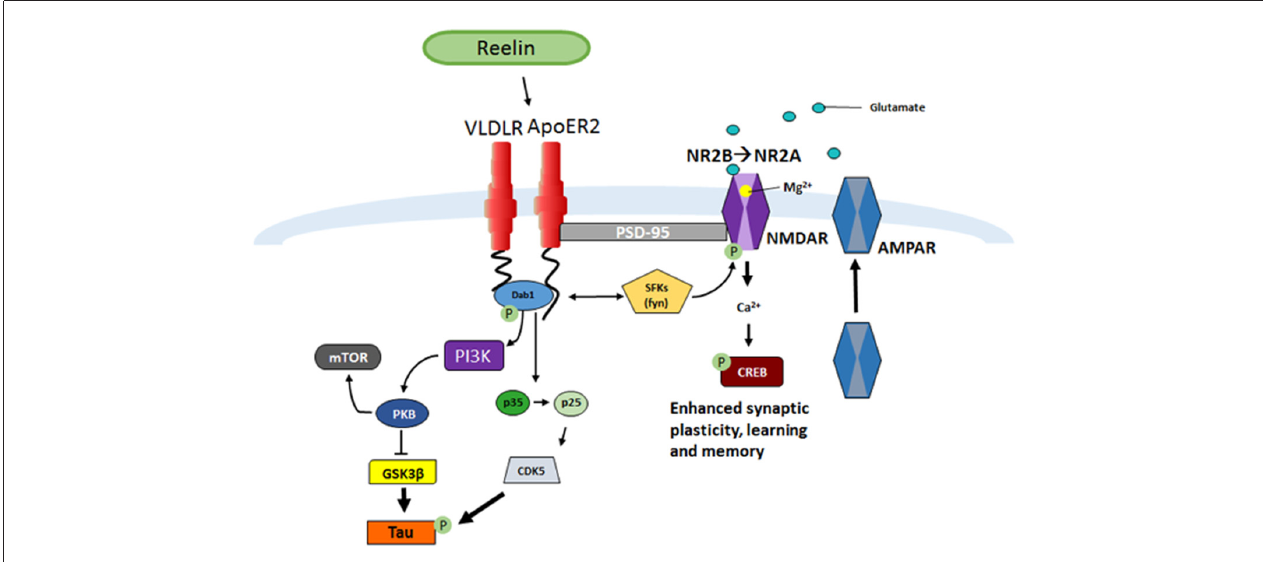
FIGURE 1 | Reelin signaling pathway in adult synaptic plasticity . Reelin binds to the lipoprotein receptors apolipoprotein receptor 2 (ApoER2) and very-low-density lipoprotein receptor (VLDLR) which causes receptor clustering and the src family tyrosine kinases (SFK) tyrosine phosphorylation of the intracellular adaptor protein Disabled-1 (Dab1), which results in the phosphorylation of N-methyl-D-aspartate receptor (NMDAR; D’Arcangelo et al., 1997, 1999; Weeber et al., 2002; Niu et al., 2004; Beffert et al., 2005; Chen et al., 2005; Qiu et al., 2006b; Qiu and Weeber, 2007; Burrell et al., 2014; Divekar et al., 2014). A subsequent increase in calcium influx leads to depolarization of the post-synaptic membrane and α -amino-3-hydroxy-5-methyl-4-isoxazolepropionic acid receptor (AMPAR) insertion (Weeber et al., 2002; Qiu et al., 2006b; Qiu and Weeber, 2007). A consequence of the increase in Ca 2 + influx and depolarization of the cell is increased CREB phosphorylation and protein synthesis, which ultimately results in increased synaptic plasticity and learning and memory (Niu et al., 2008; Rogers et al., 2011, 2013). Another result of Dab1 phosphorylation is activation of phosphatidylinositol-3-kinase (PI3K), protein kinase B (PKB/Akt), and modulation of Glycogen synthase kinase 3 beta (GSK3 β ), which inhibits Tau phosphorylation (Beffert et al., 2002). Phosphorylation of Dab1 also regulates the conversion of p35 to p25 and results in activation of CDK5, also responsible for Tau phosphorylation (Beffert et al., 2004).